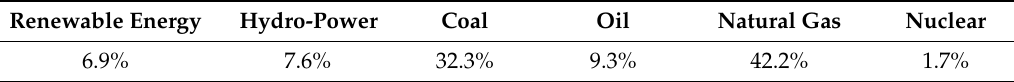
Table 1. The proportion of electric power generations for the 2016 fiscal year in Japan. Renewable Energy Hydro-Power Coal Oil